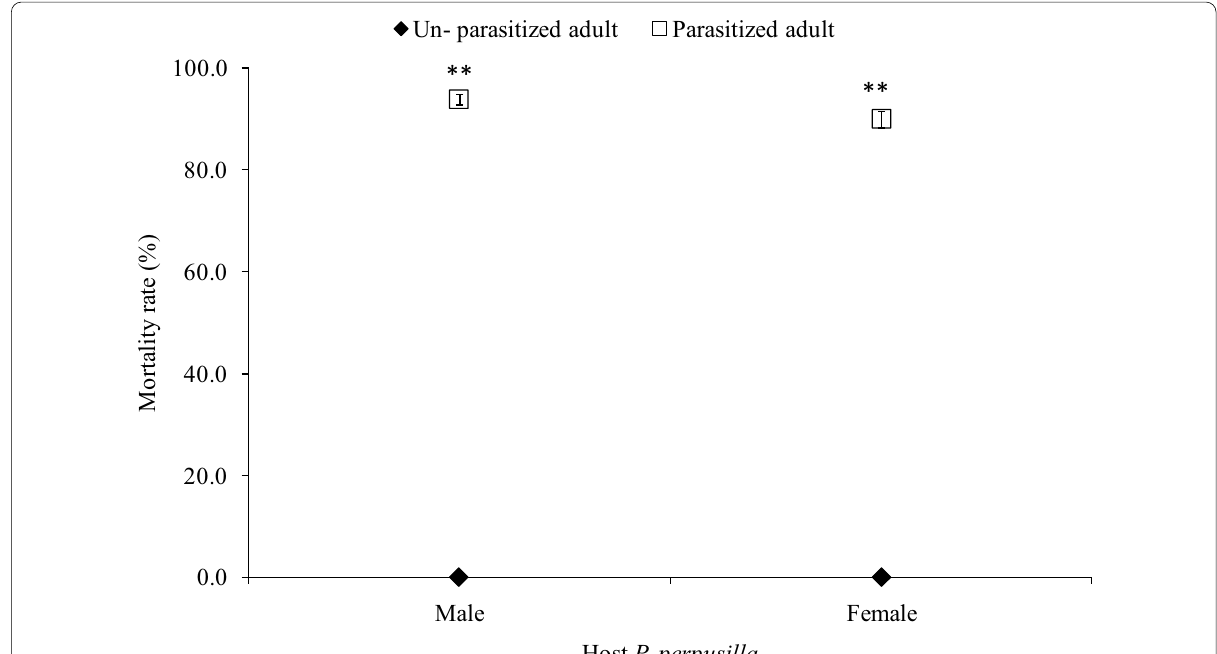
Fig. 4 Mortality of host P. perpusilla when male and female adults were offered to parasitoid F. melanoleuca for parasitism as against un-parasitized nymphs; “**” within a column indicate ( p < 0.05) significant difference; the results are presented as the means